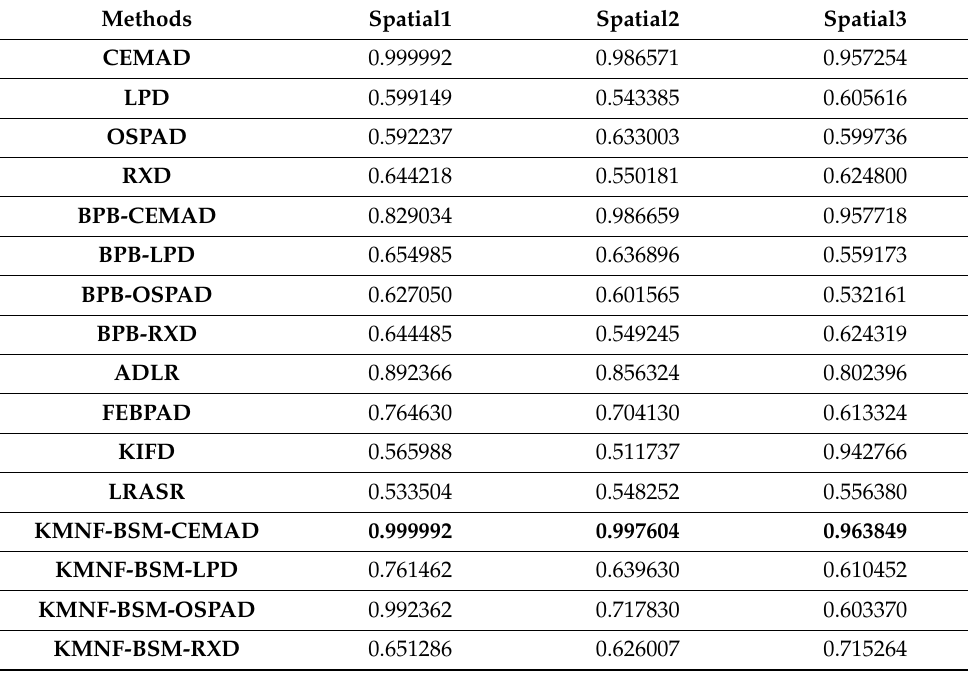
Table 4. The AUC ( D,F ) values of HSIs with different spatial resolutions.